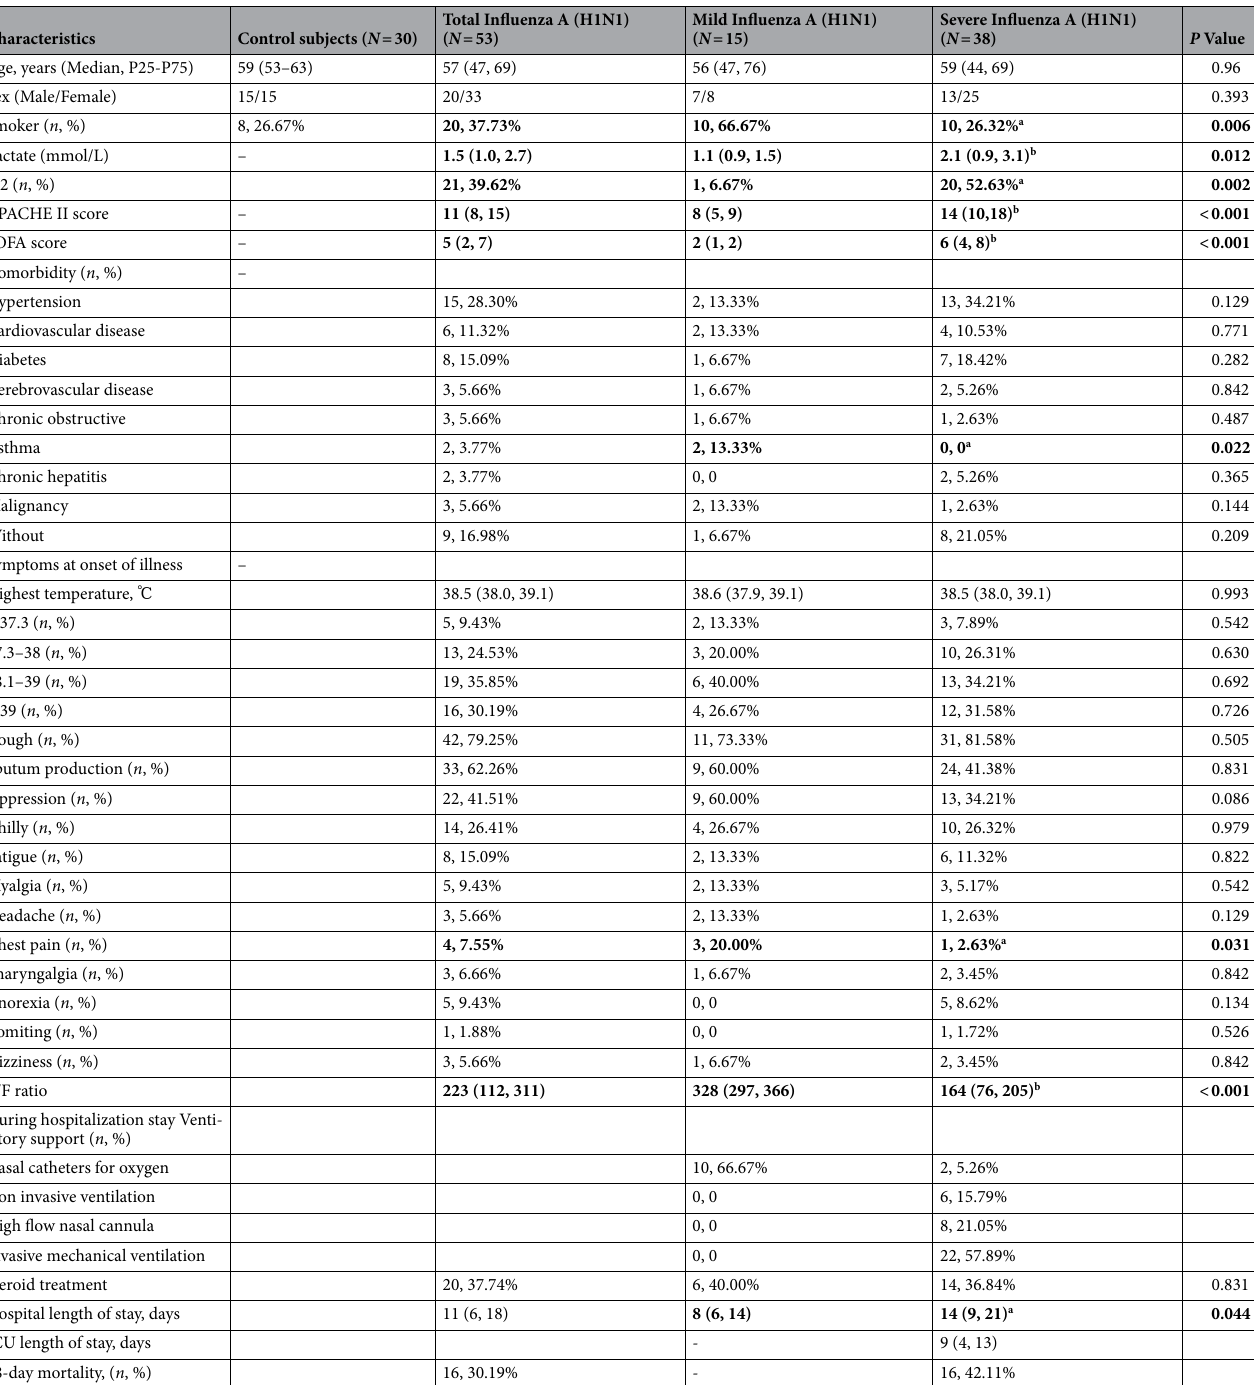
Table 1. Characteristics and symptoms of patients infected with Influenza A (H1N1). Data are expressed as median (inter-quartile range), mean ± SD, or number (%). Abbreviations: APACHE, Acute Physiology, Age, Chronic Health Evaluation; SOFA, Sequential organ failure assessment; P/F, PaO 2 /FiO 2 . a, vs. Mild group, χ 2 tests; b, vs. Mild group, Mann–Whitney U test. Kruskal–Wallis test was used between the age of control, mild and severe groups; χ 2 test was used between the male to female ratio of control, mild and severe groups. –, This data were not collected